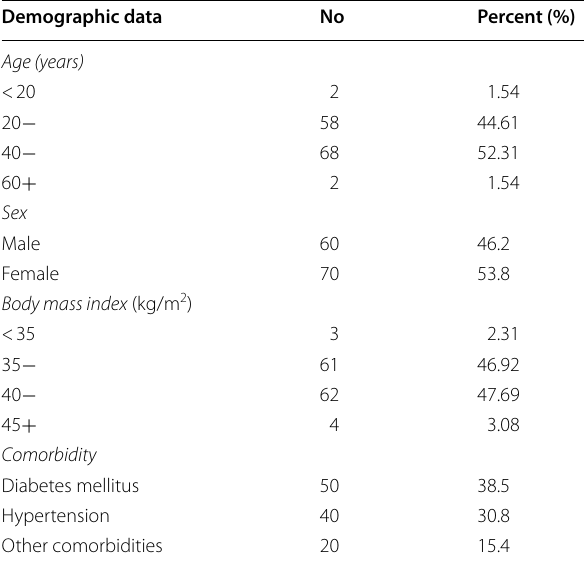
130) Table 2 Liver enzymes and lipid profile among the studied =